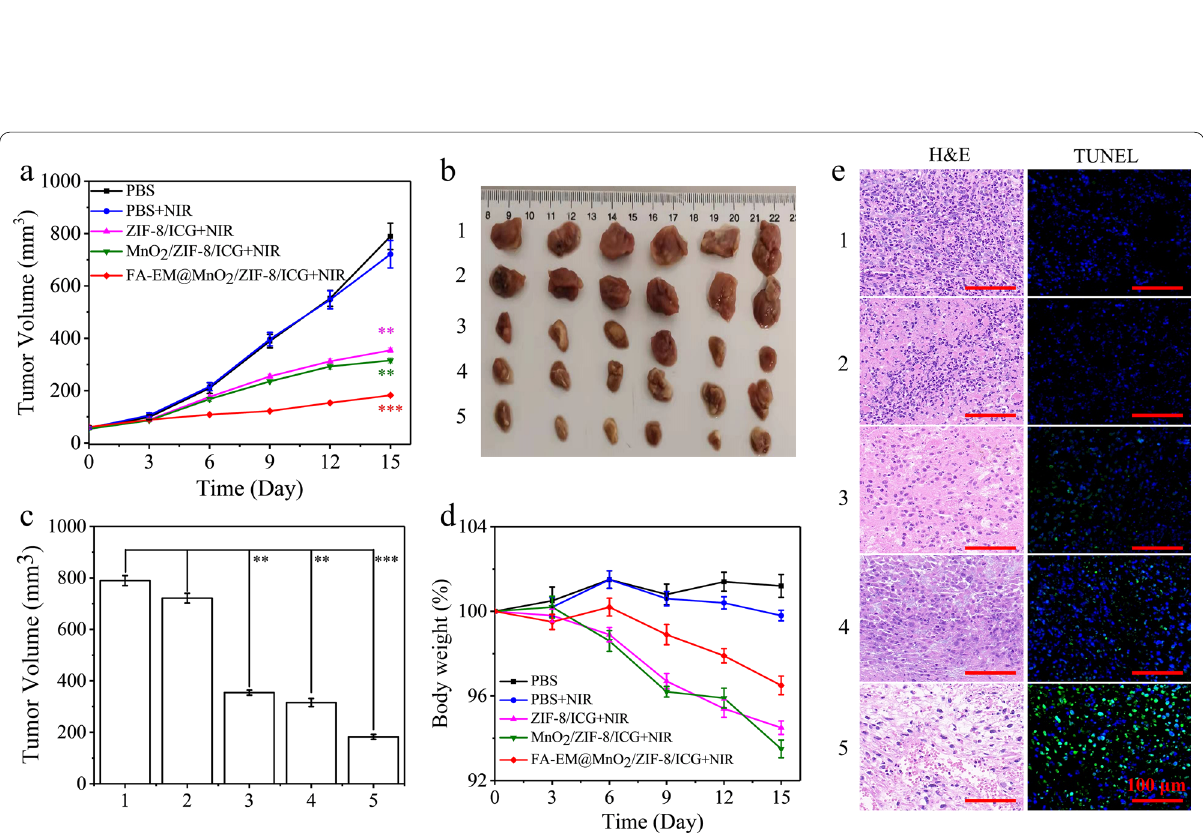
Fig. 7 a The tumor volumes in six different groups after treatment. b Photographs of the tumors on day 15 post-injection, and c Mean tumor weights on day 15 after the last treatment of PBS (1), PBS (5). d Body weight of mice in different groups during treatment. e H&E (left) and TUNEL staining (right) of tumor slices collected from 4T1 tumor-bearing mice after treatment of PBS (1), PBS bars: 100 μm. Significant differences (*: p < 0.05; **: p < 0.01; ***: p < 0.001) among different groups are